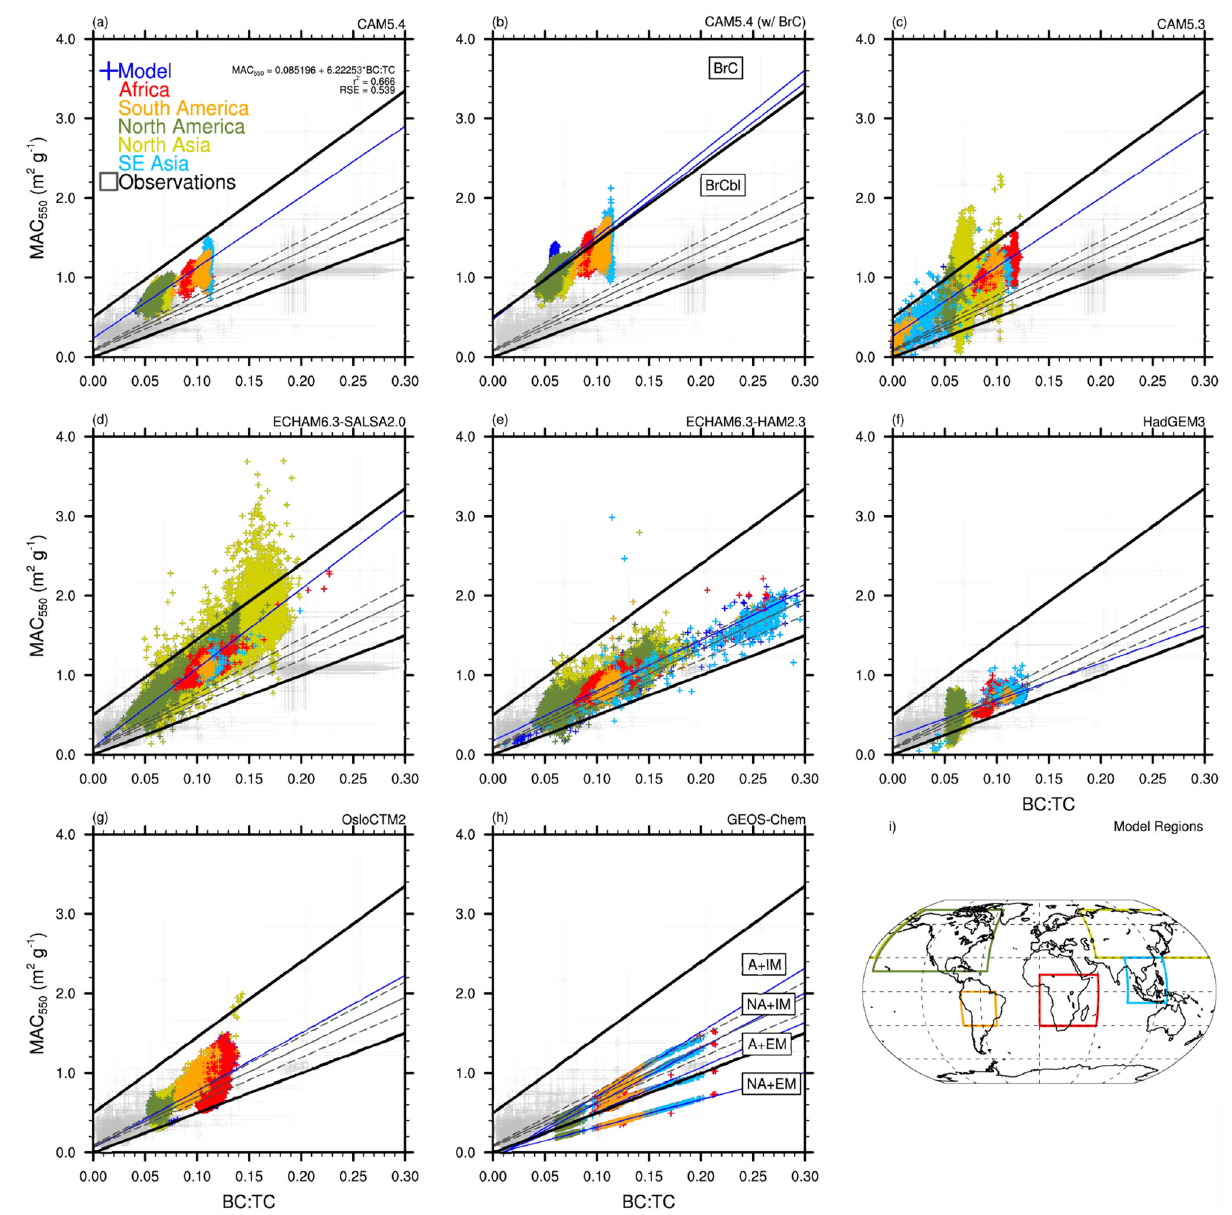
Fig. 3 Comparison of observed and modeled biomass burning mass absorption cross-section versus black carbon to total carbon ratio. Biomass burning (BB) mass absorption cross-section (MAC) depends on the 550 nm absorption coef fi cient ( β a ), as well as BB black carbon and organic aerosol concentrations ([BC], [OA]) (MAC = β a /([BC] + [OA]; m 2 g -1 ). All panels plot BB MAC versus black carbon to total carbon ratio (BC:TC). Observations are in gray. The model data is from a this study, b Brown et al. 17 , c – g AeroCom Phase-III simulations, and h Saleh et al. 16 . They are a CAM5.4, b CAM5.4 (w/ brown carbon (BrC)), c CAM5.3, d ECHAM6.3-SALSA2, e ECHAM6.3-HAM2.3, f HadGEM3, g OsloCTM2, and h GEOS-Chem. Model data is representative of BB in fl uenced regions which are color-coded in the model output and are speci fi ed on the global plot in i , de fi ned as Africa (red), South America (orange), North America (green), Northern Asia (yellow), and Southeastern Asia (light blue). The two CAM5.4 simulations with BrC b represent brown carbon with and without photochemical bleaching (BrC and BrCbl, respectively). The four GEOS-Chem simulations h represent the four model simulations from Saleh et al. 16 : no BrC and externally mixed aerosols (NA + EM); BrC and externally mixed aerosols (A + EM); no BrC and internally mixed aerosols (NA + IM); and BrC and internally mixed aerosols (A + IM). The solid gray line is the best fi t to observations, with dashed lines representing the 95% con fi dence intervals of the fi t. Thick black lines constrain a reasonable range in BB MAC 18 . The best- fi t to the model data is represented by the solid blue